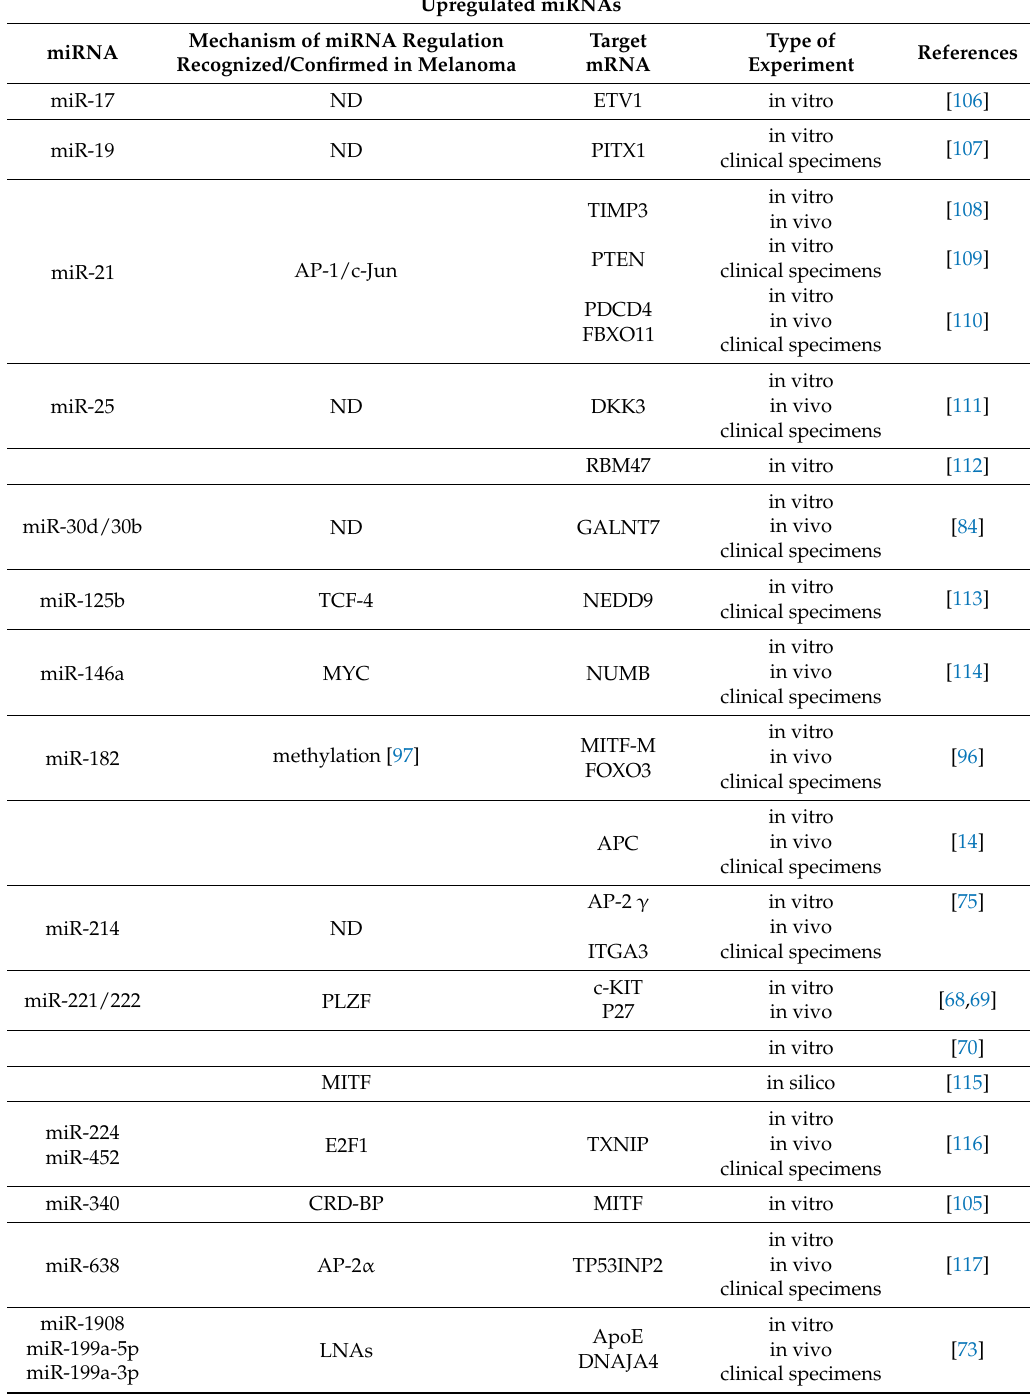
Table 1. Invasiveness-associated miRNAs, exhibiting either upregulated (oncomiRs) or downregulated (tumour suppressor miRs) expression in